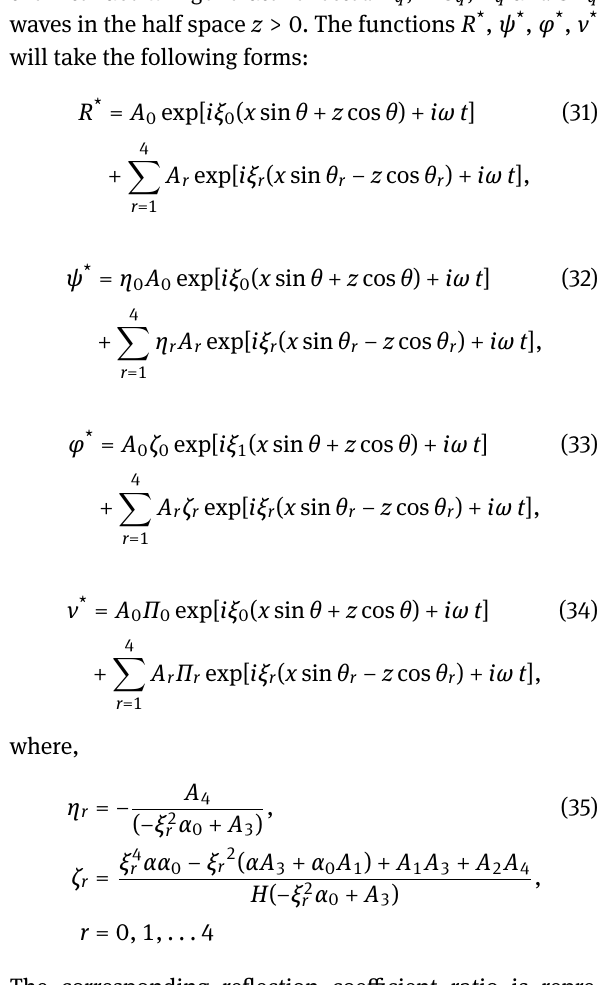
Figure 1, indicate that for incident P or SV wave at the interface will generate reflected P waves in the half space z > 0. The functions R * , ψ * , φ * , ν